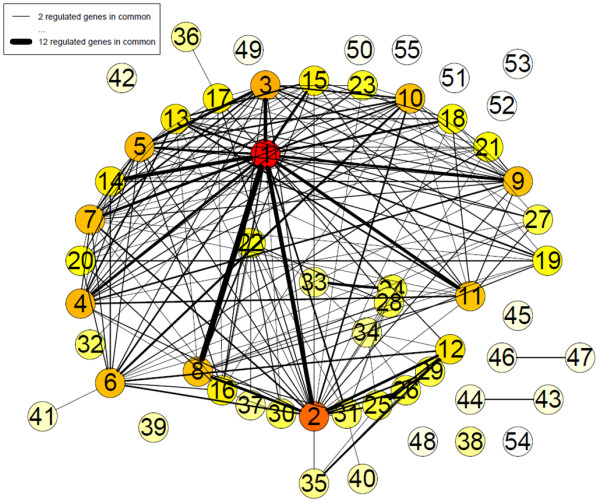
Higher order network of interactions among EGF-regulated genes. Network of genomic interactions among EGF-regulated pathways (Holm-adjusted p-value < 0.01) as defined by GlobalAncova using KEGG database functional annotation. Nodes (pathways) that have at least two regulated genes (as defined by RankProd analysis) in common with other pathways are connected by continuous lines to these other pathways. The strength of each pathway interconnection (i.e. the number of shared regulated genes) is expressed by the width of the continuous lines connecting the two nodes. The node color indicates the interconnectivity of the nodes ranging from no connection to any other pathway (white) to many connections with other pathways (red). Numbers define KEGG categories as listed in Table 3.